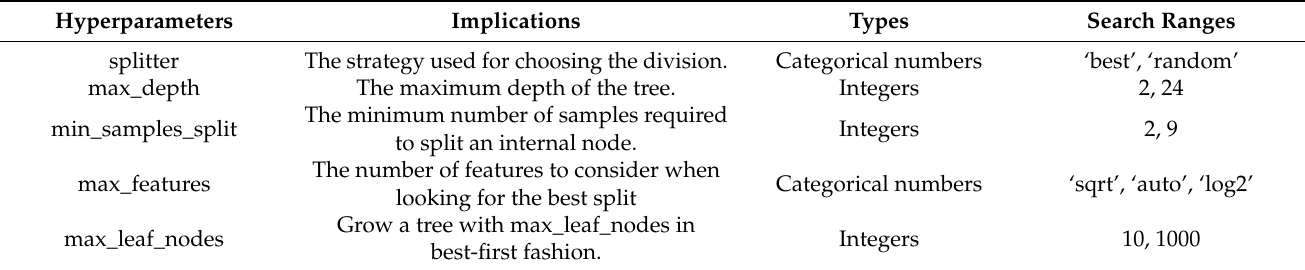
Table 4. Hyperparameters of the decision tree model tuned in this study